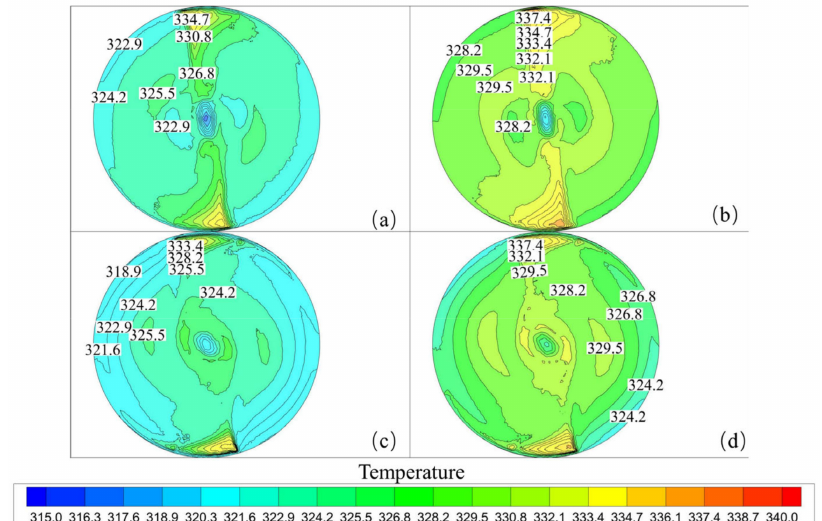
Figure 8. Temperature distribution at different positions: ( a ) 10 ◦ cross angle at 0.15696 m; ( b ) 10 ◦ cross angle at 0.17472 m; ( c ) 15 ◦ cross angle at 0.15725 m; ( d ) 15 ◦ cross angle at 0.17425